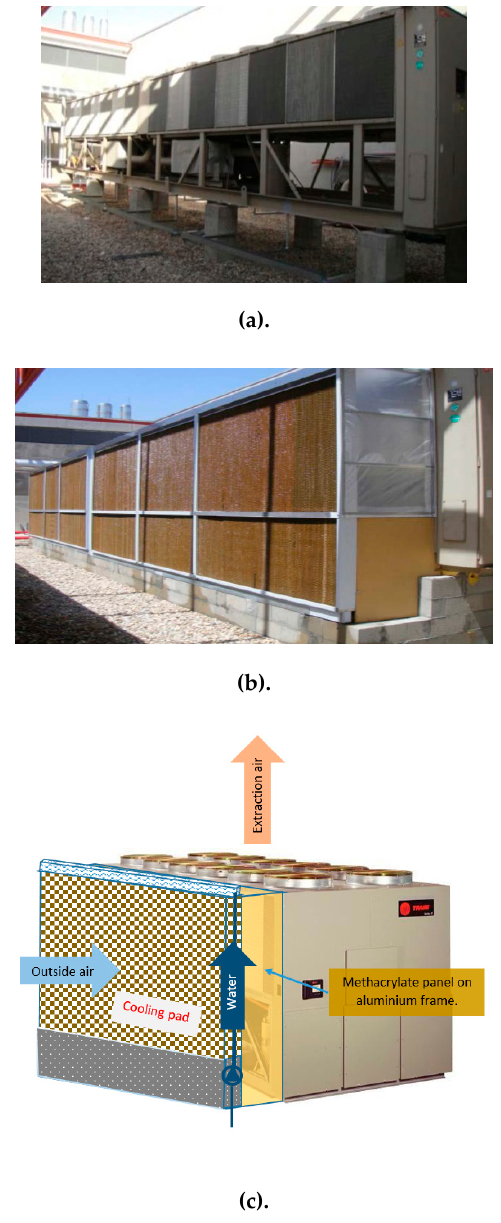
Figure 5. Chillers without ( a ) and with ( b ) evaporative cooling pads, ( c ) Schematic diagram.